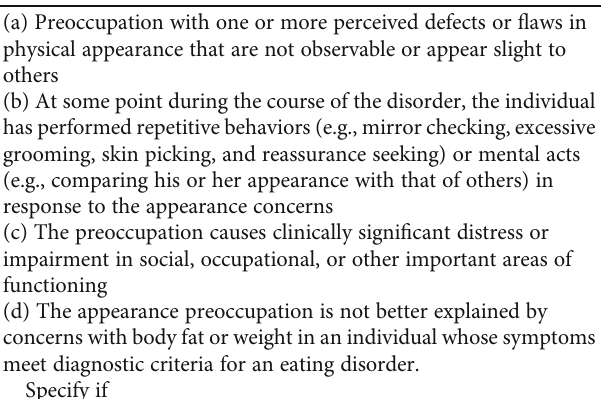
Table 1: DSM-V-TR diagnostic criteria for body dysmorphic disorder.